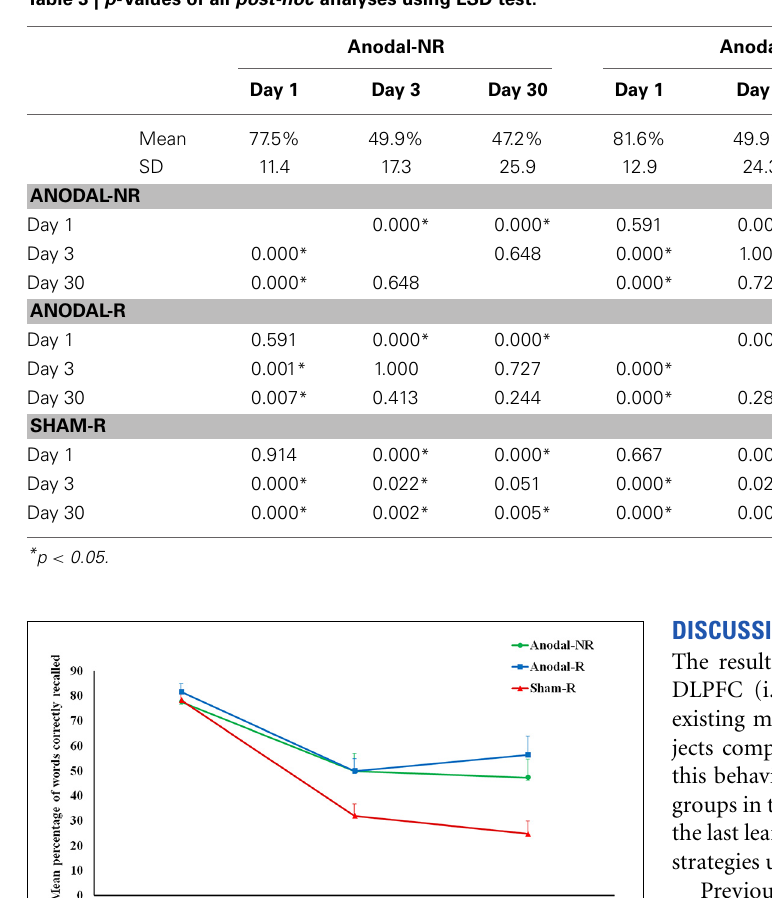
Table 3 | p -Values of all post-hoc analyses using LSD